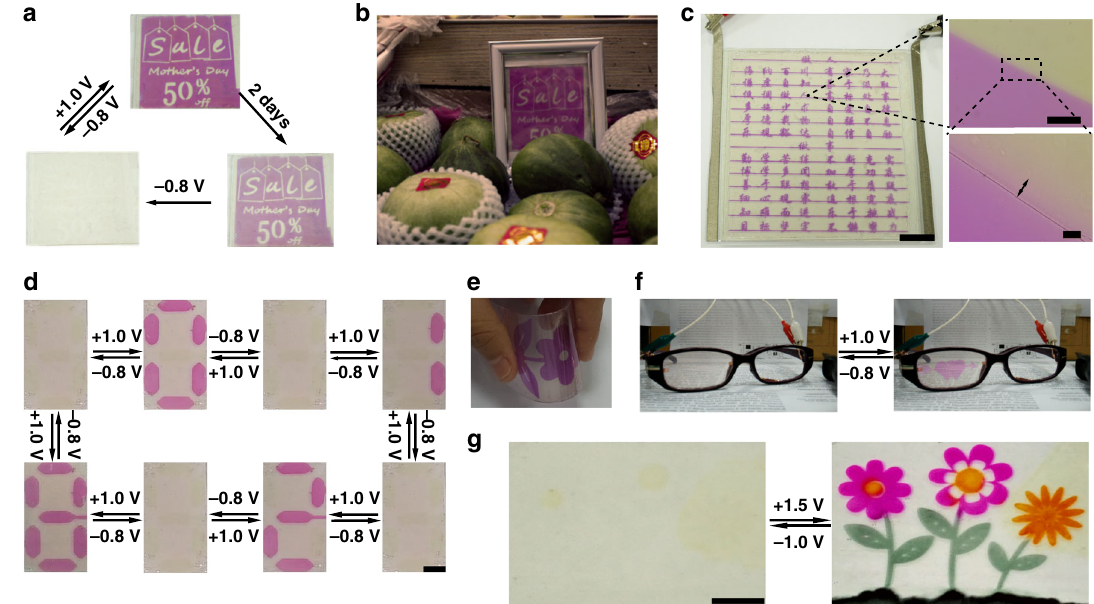
Fig. 3 Potential applications of bistable solid devices. a The e-billboard prototype (10 cm× 10 cm) performance. b The prototype for supermarket e- billboard/reader. c The prototype for high-resolution e-reader/display, the scale bars are 2 cm, 200 μ m, 20 μ m, respectively. d The prototype for pixel e- billboard/reader, scale bar: 1 cm. e The prototype for fl exible display. f The prototype for wearable thin- fi lm display on eye-glasses. g The prototype